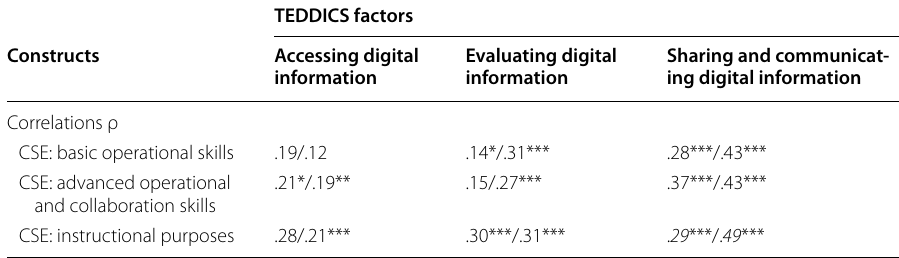
Correlations among latent variables for the male sample are reported before the slash. Significantly different correlations are shown in italics. Differences in correlations were tested using the Wald χ 2 test (see Additional file 1: C1) * p < .05, ** p < .01, *** p <